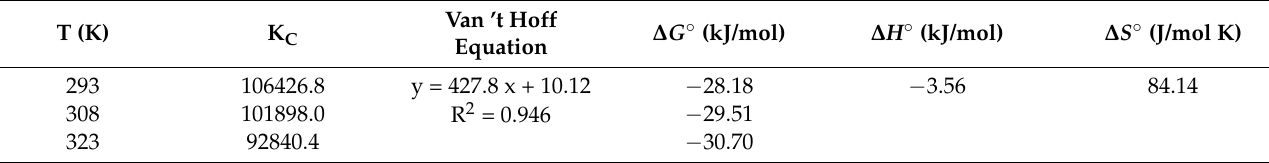
Table 7. Thermodynamic parameters for CV dye adsorption process onto DSD adsorbent. T